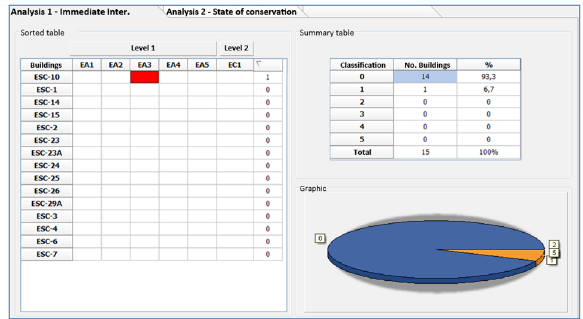
Figure 7: ICT platform application for evaluation of status of wooden stilt-houses conservation, in Escaroupim: the identification of needs for immediate intervention in vernacular wooden stilt- houses.